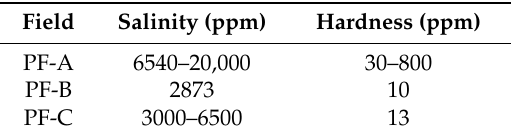
Table 7. Salinity and hardness of offshore fields.